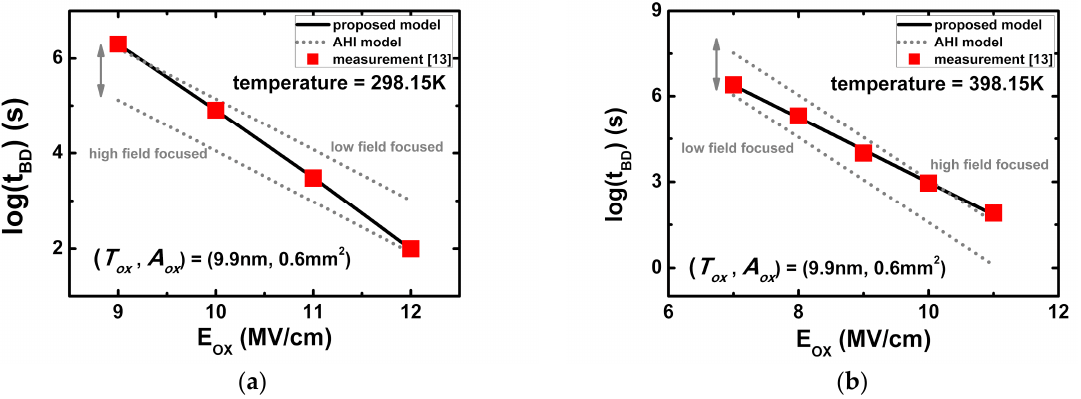
Figure 4. Lifetime versus E ox plot obtained from the proposed TDDB hybrid model and actual measured data: ( a ) Lifetime at low temperature (298.15 K); ( b ) Lifetime at high temperature (398.15 K).